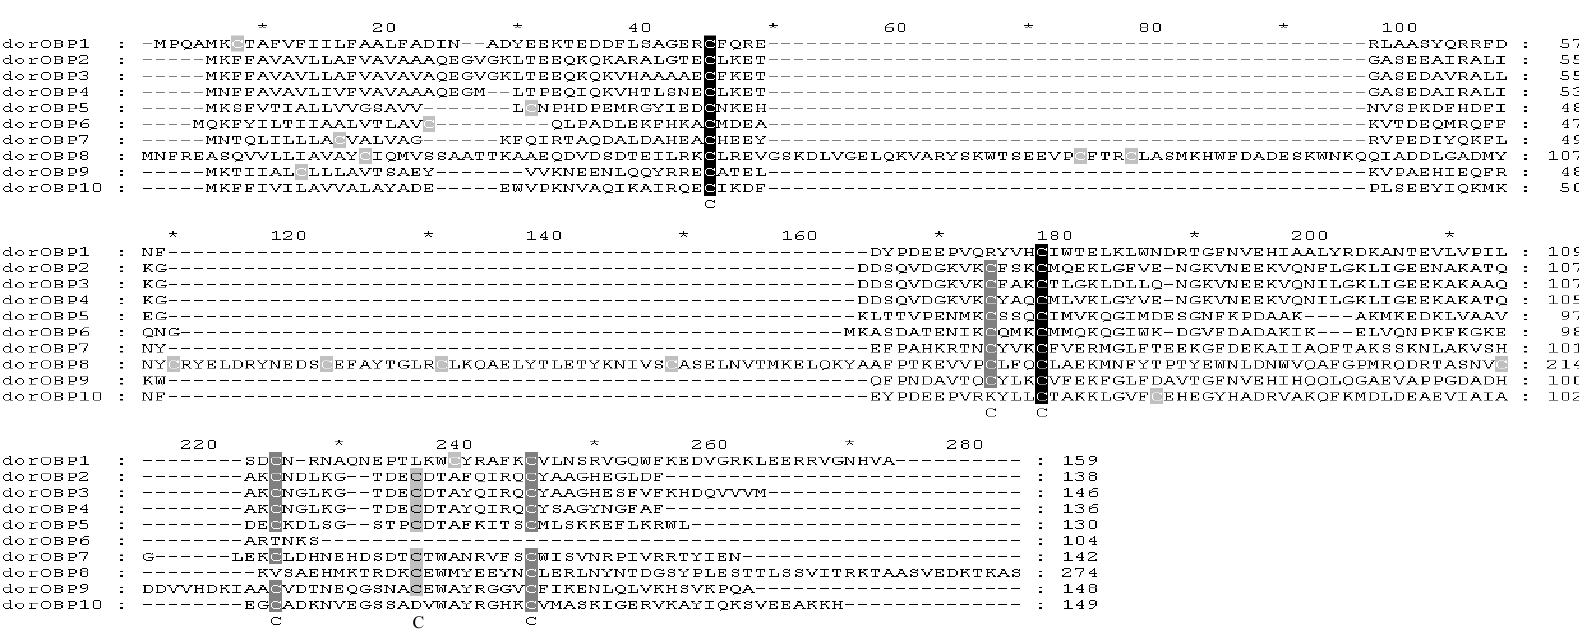
Figure 2. Alignment of the identified B. dorsalis OBPs. The classical OBPs: BdorOBP1, BdorOBP2, BdorOBP3, BdorOBP4, BdorOBP5, BdorOBP7, BdorOBP9. “Dimer” OBP: BdorOBP8. The Minus-C OBPs: BdorOBP10. Full-length amino acid sequences of BdorOBPs are aligned by ClustalX 1.83 (Multiple sequence alignment program, Thompson JD, IllkirchCedex, France) and edited using GeneDoc